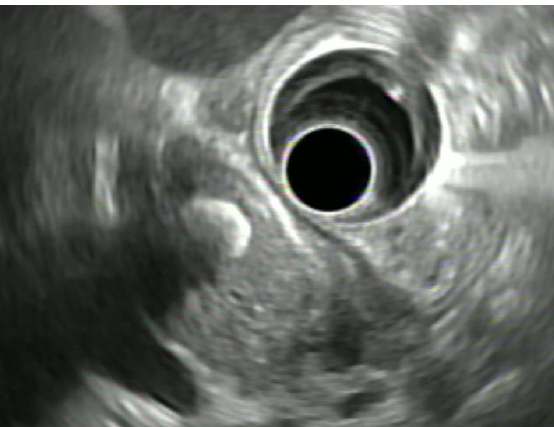
Figure 1. Radial EUS scan of the distal CBD from the second portion of the duodenum showing a stone in front of the papilla. CBD – common bile duct.